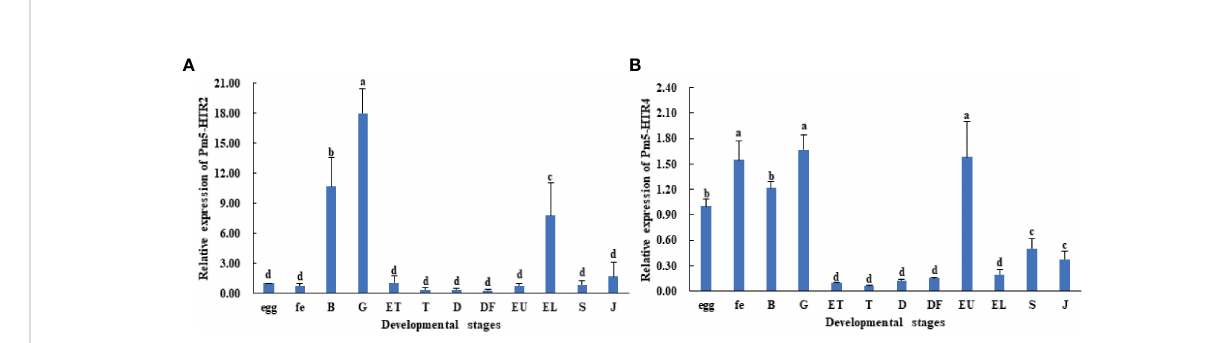
FIGURE 5 Expression pattern of Pm5-HTR2 (A) and Pm5-HTR4 (B) in development stages. Bars with different superscripts indicate signi fi cant differences ( P < 0.05). E, egg; FE, fertilized egg; B, blastula; G, gastrula; ET, early trochophore; T, trochophore; D, D-stage larvae; DF, D-stage larvae before feeding; EU, early umbo larvae; EL, eyed larvae; S, spat; J,